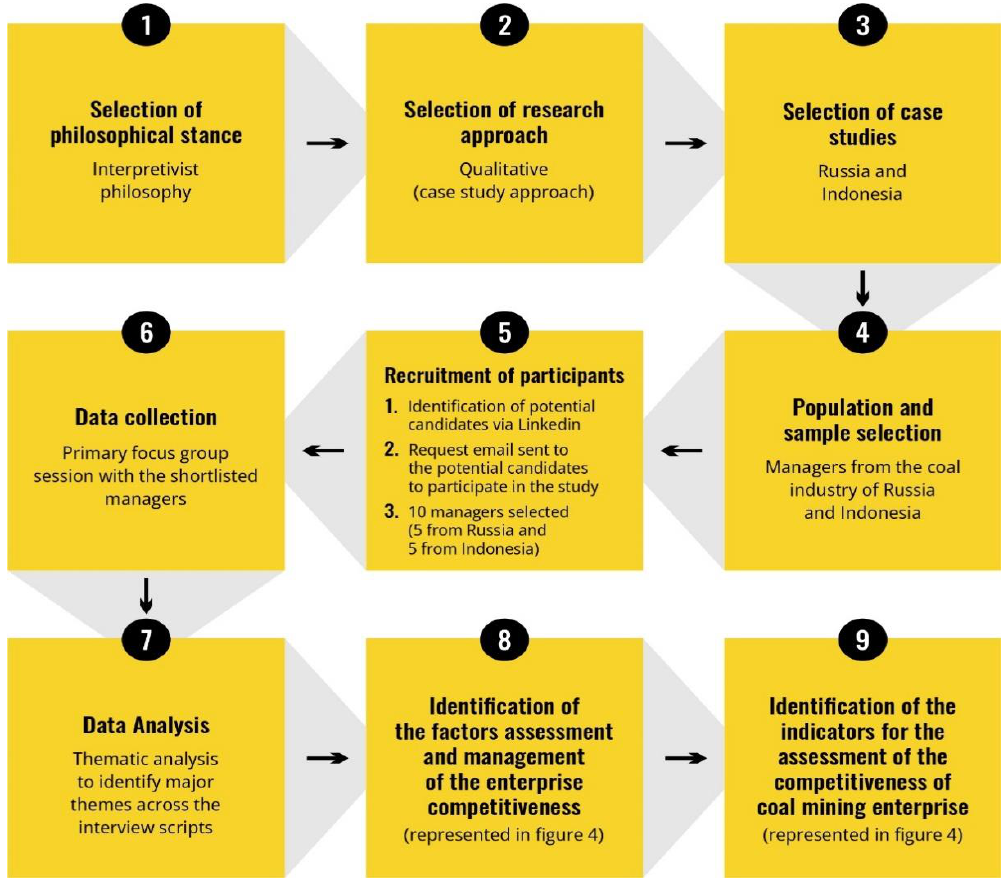
Figure 4. The methodology